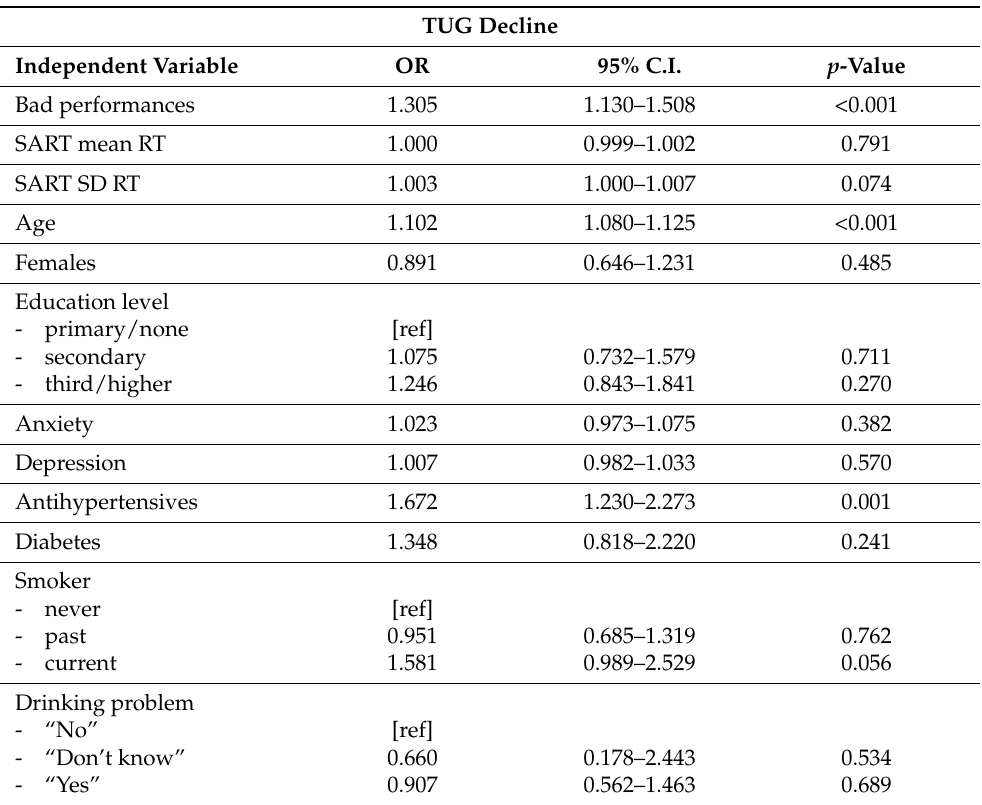
Table A2. Results for the fully adjusted per covariates binary logistic regression model 4a considering bad performances as potential predictor and having TUG decline as